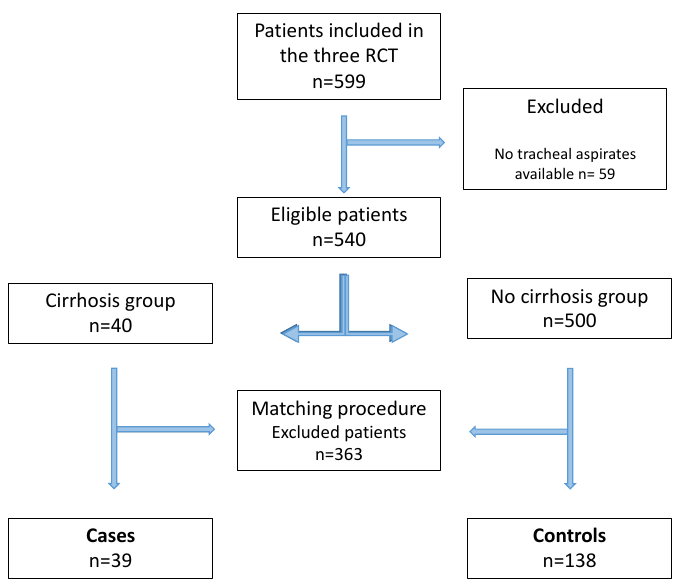
Figure 1. Flowchart of the study. RCT: randomized controlled trial.